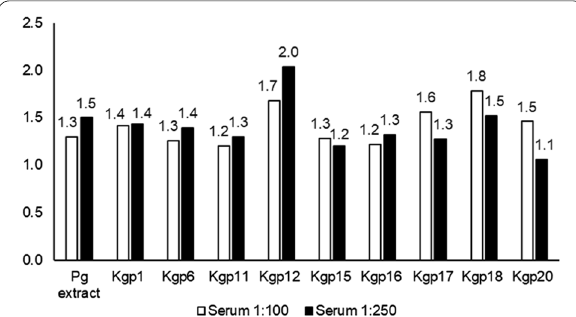
IgG immunoreactivity of peptides